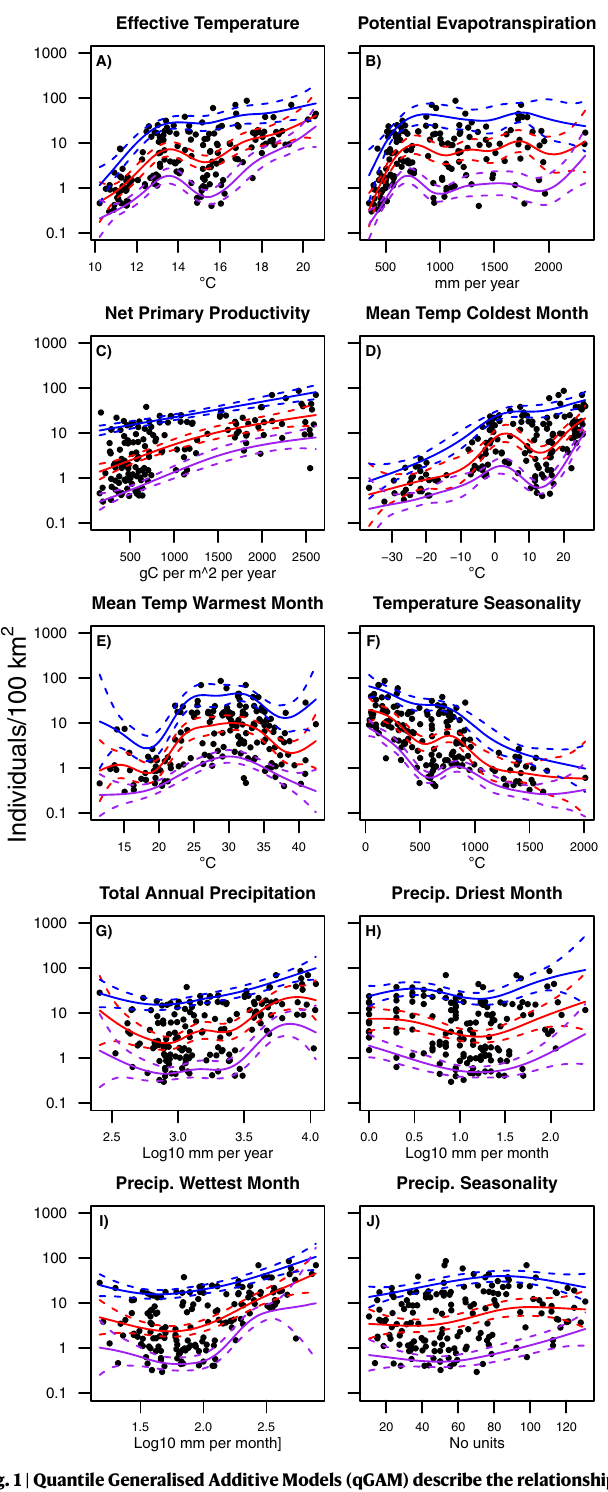
Fig.1 |QuantileGeneralisedAdditiveModels(qGAM)describetherelationship between environmental factors and population density. Quantile Generalised Additive Models (qGAM) describing the relation between environmental factors andpopulationdensityfor A Effectivetemperature, B Potentialevapotranspiration, C Net primary productivity, D Mean temperature of the coldest month, E Mean temperature warmest month, F Temperature seasonality, G ) Total annual pre- cipitation, H Precipitation driest month, I Precipitation wettest month and J Precipitation seasonality. Lines on each panel show the 10th percentiles (purple lines), 50th percentiles (red lines), and 90th percentiles (blue lines). Solid lines show the mean predicted values, and dashed bands indicate the 95% con fi dence intervals of each model